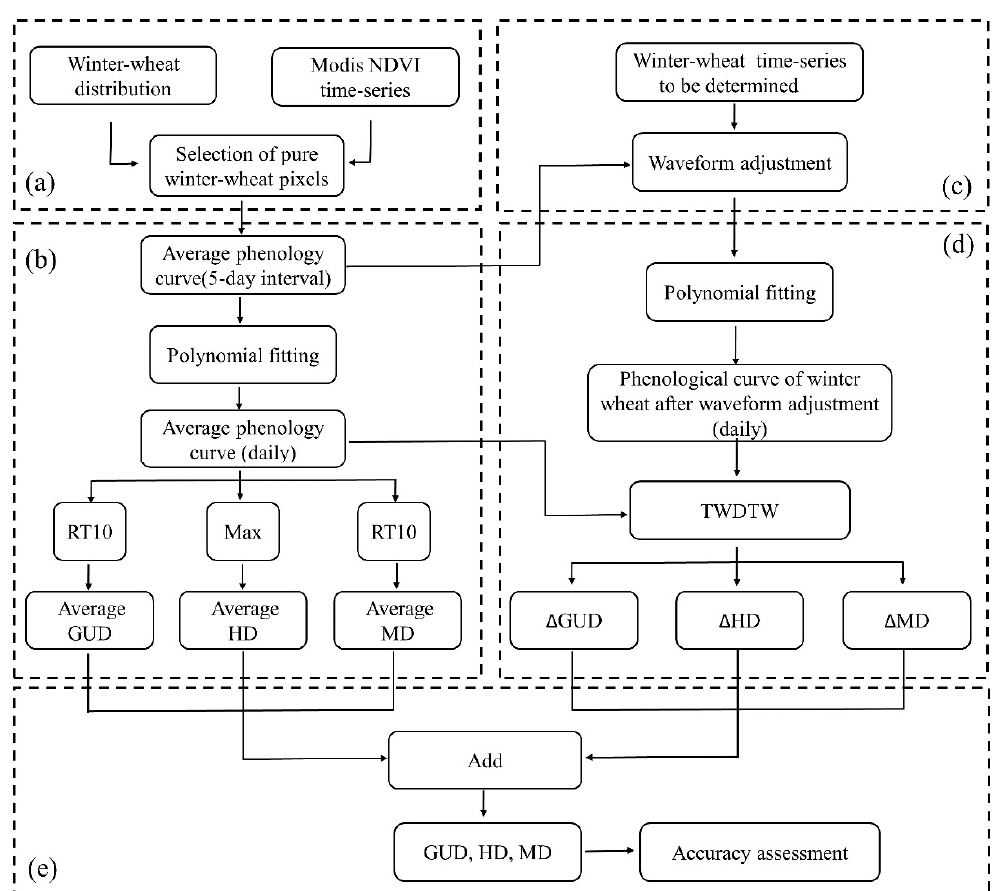
Figure 4. Workflow of the time-weighted dynamic time warping (TWDTW) method for determining the phenological phases of winter wheat. ( a ) Selection of pure winter-wheat pixels. ( b ) Definition of the average GUD, HD, and MD. ( c ) Waveform adjustment. ( d ) Calculation of the difference between each NDVI phenological curve and the average phenological curve. ( e ) Determination of key winter-wheat phenological phases and accuracy assessment.